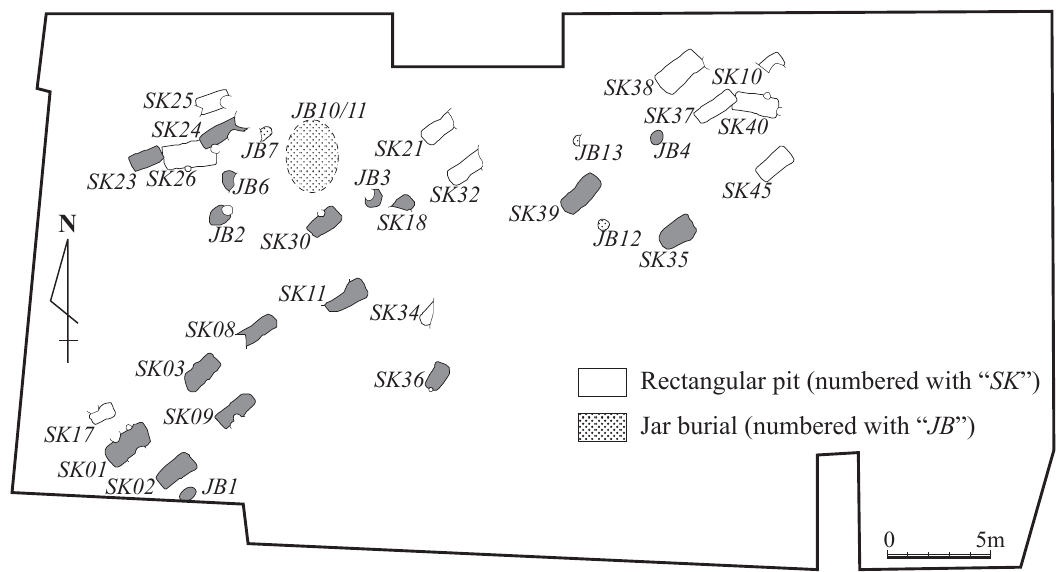
Figure 2. Two types of burial in the Early Yayoi cemetery of the Mochida-Cho San-Chome site. A: Rectangular pit for a single grave. This is SK02 viewed from the south-west. Most pit graves measure 2m by 1m, about half of them having offering vessel(s) whose height is around 12cm. Some pit graves have a stone arrangement inside, along with walls. B: A jar burial. This is JB2 viewed from the north-west. Jar burials are placed in a prepared pit lying down, some of them with a covering pot. The height of the burial-jar is more than 60cm. (after Ehime Prefecture Archaeology Center (1985)).